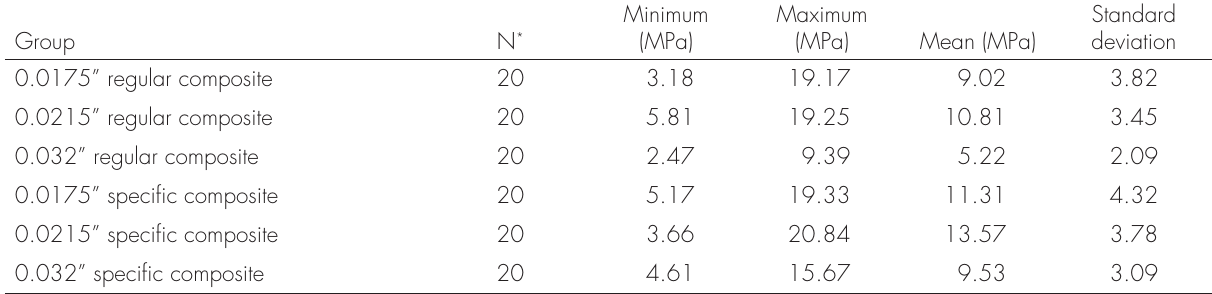
Table II. Descriptive statistics for shear bond strength according to groups.